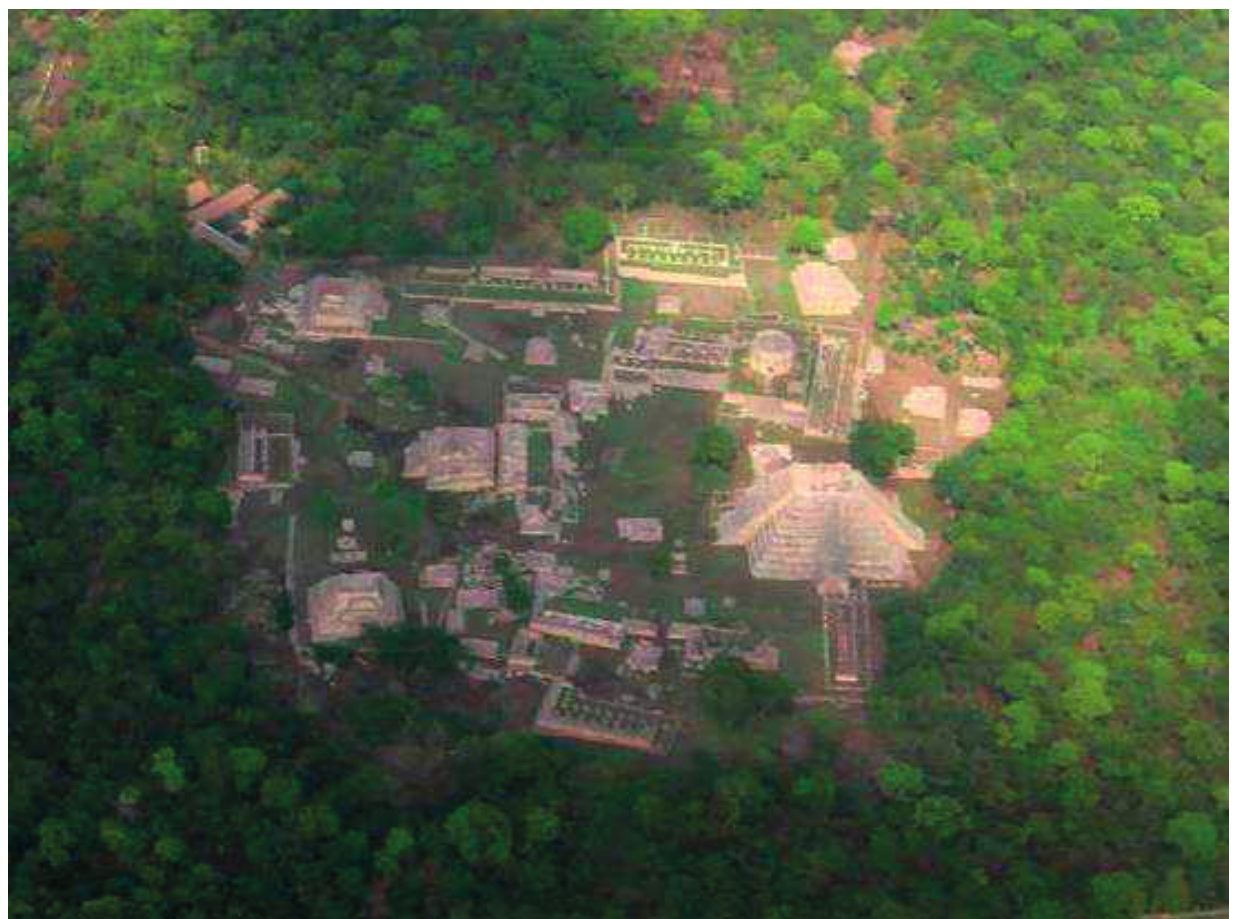
Figure 3. Photo of Mayapán’s reconstructed monumental